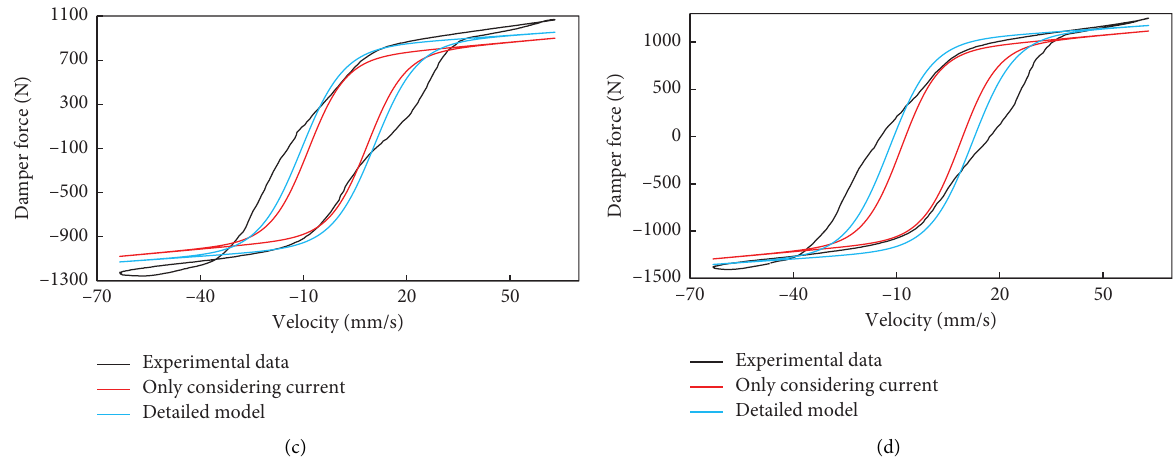
Figure 18: Damper force calculation results, hyperbolic tangent model, at 2Hz excitation with amplitude of 5mm. (a) Input current � 0.4A. (b) Input current � 0.6A. (c) Input current � 0.8 A. (d) Input current � 1A.